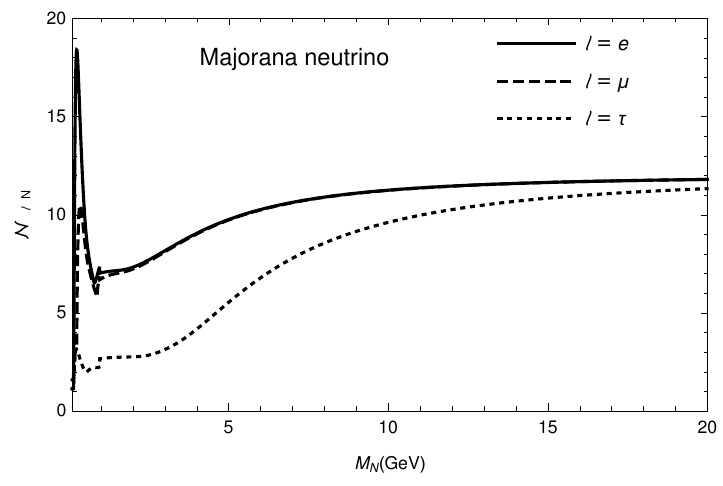
Figure 2 . The factors N ‘N appearing in the Majorana neutrino decay width eqs. (2.34)–(2.36), as a function of the mass M N of the Majorana neutrino N j